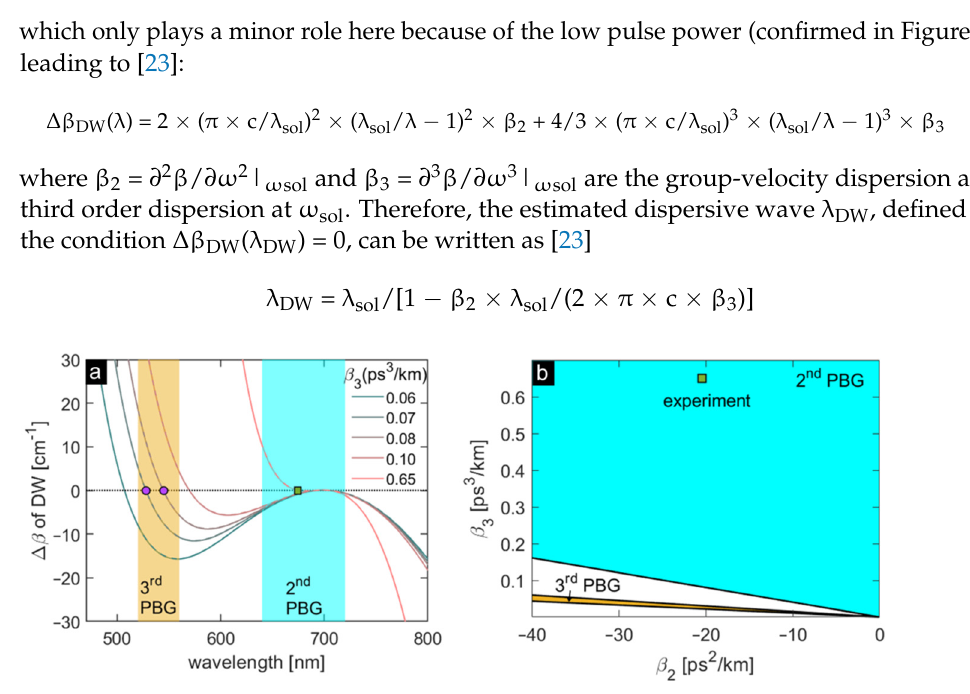
Figure 6. ( a ) Analytical description of the phase-mismatching rate Δβ DW as a function of β 3 in the second order PBG with β 2 = − 20.4 ps 2 /km corresponding to Δλ = 20 nm case. The solid lines indicate Δβ DW neglecting the nonlinear phase (Equation (3)) while the dashed lines indicate Δβ DW with the nonlinear phase (Equation (2), γ = 6.5 W − 1 /km, N = 1.6, P sol = 1 kW corresponding to DW generation threshold in Figure 3b). The cyan bar indicates the second order PBG and the yellow bar indicates the third order PBG of the sample. The green square corresponds to the Δλ = 20 nm case in Figure 3b. The purple dots indicate the DW generated across the resonance band; ( b ) the estimated DW wavelength for different combinations of β 2 and β 3 from Equation (4) (soliton wavelength λ sol = 699 nm corresponding to the Δλ = 20 nm case). The cyan area indicates the second order PBG and the yellow area indicates third order PBG of the sample. The green square indicates the generated DW in the experiment for the Δλ = 20 nm case.